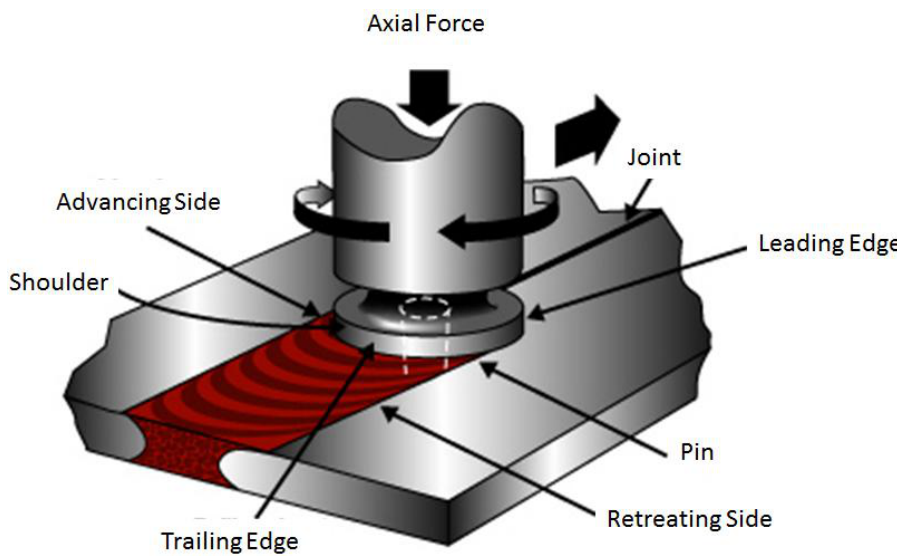
Figure 1. Friction stir welding